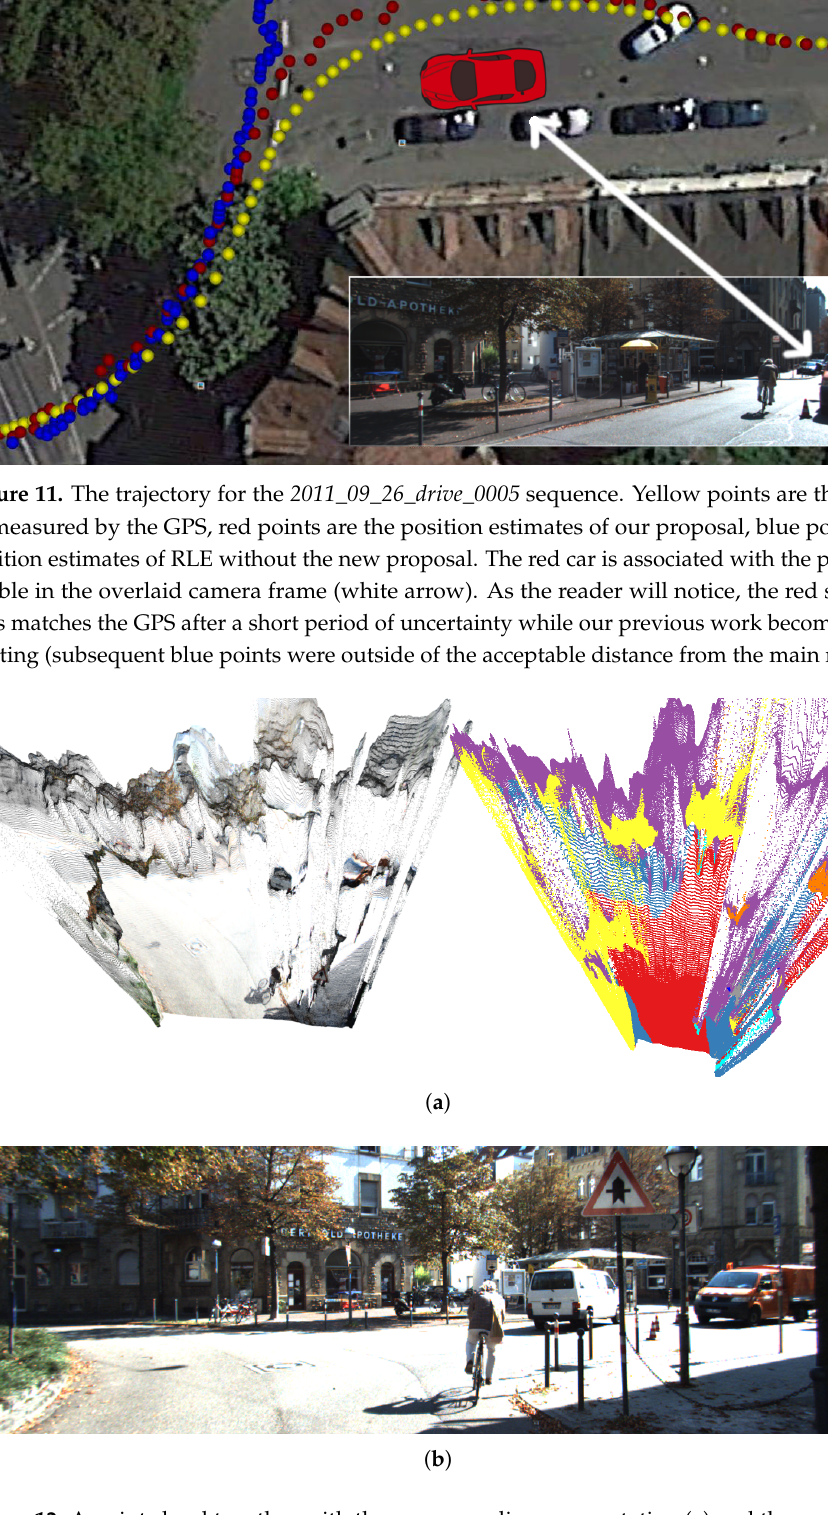
Figure 12. A point cloud together with the corresponding segmentation ( a ) and the corresponding RGB image ( b ) from sequence 2011_09_26_drive_0005 . The reader can appreciate that there is too much noise and distortion to obtain a proper alignment with OpenStreetMap